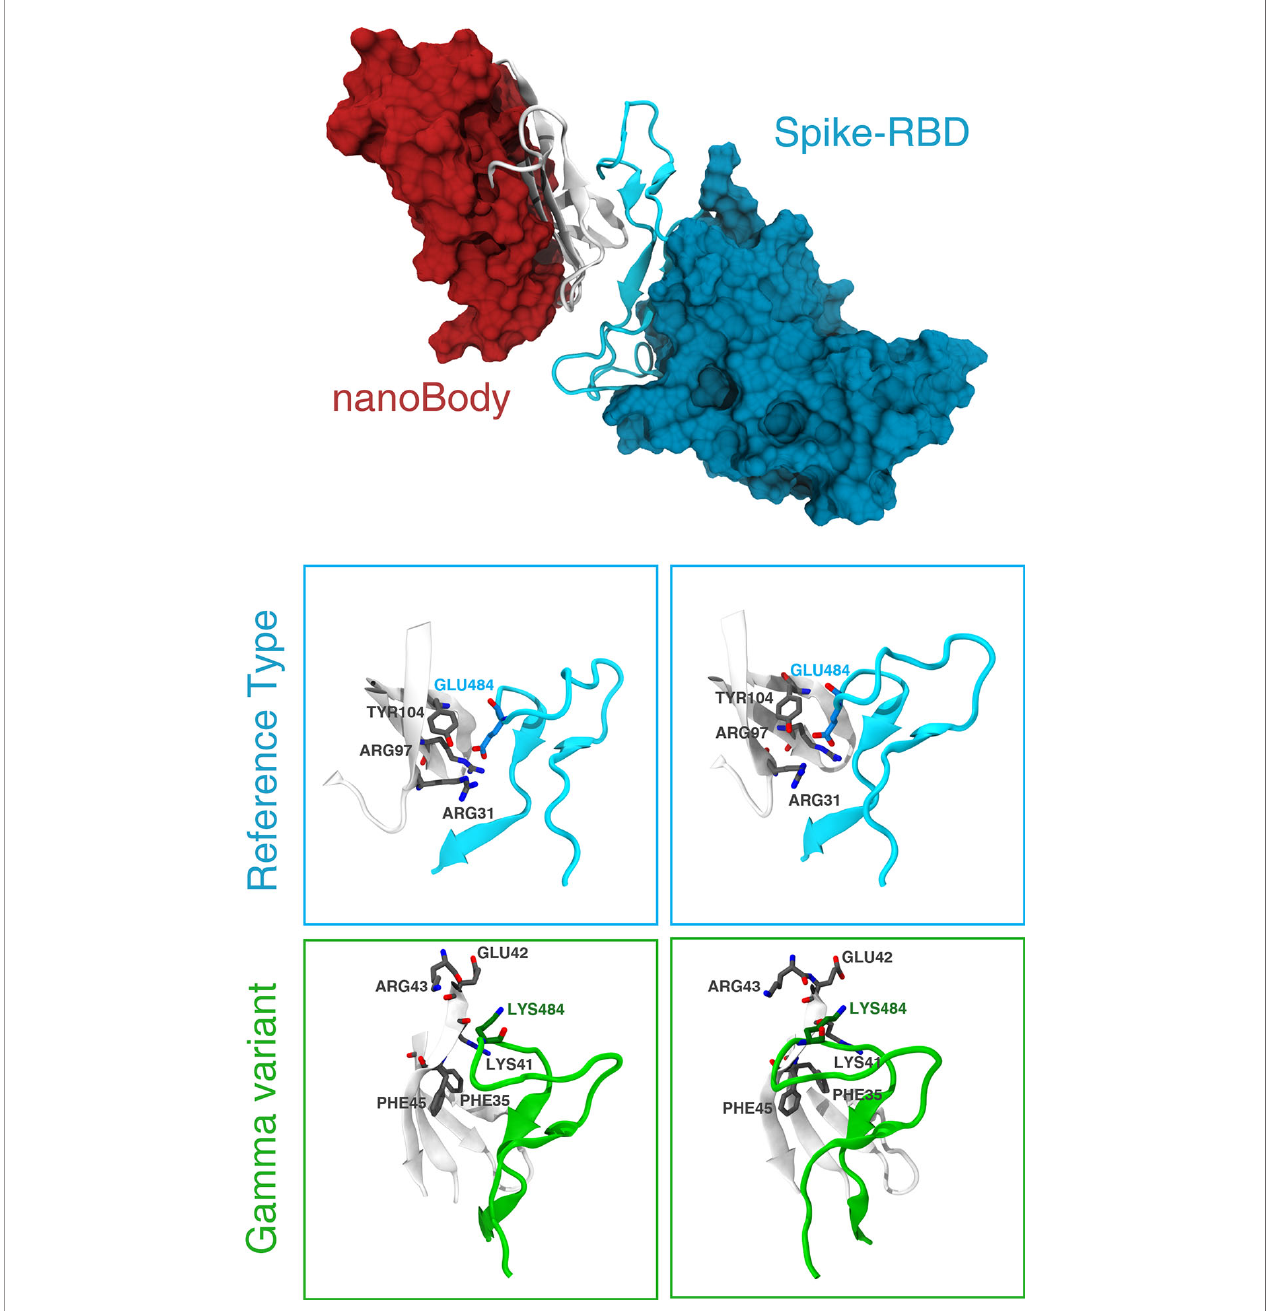
FIGURE 5 | Details of the interaction between the nanobody and the gamma variant. The top panel shows the binding between the S-RBD region of the RT and the neutralizing nanobody Nb20. The interface of interaction is shown in cartoon representation (white for the Nb20 and cyan for S-RBD), while the rest of the protein is represented according to its surface (red for Nb20 and blue for S-RBD). The bottom panels show the differences between RT (cyan) and gamma variant (green) in stereographic representation. The positively charged Arg31 recognizes the negatively charged Glu484 in S-RBD in Nb20. This bond is clearly broken after the E484K